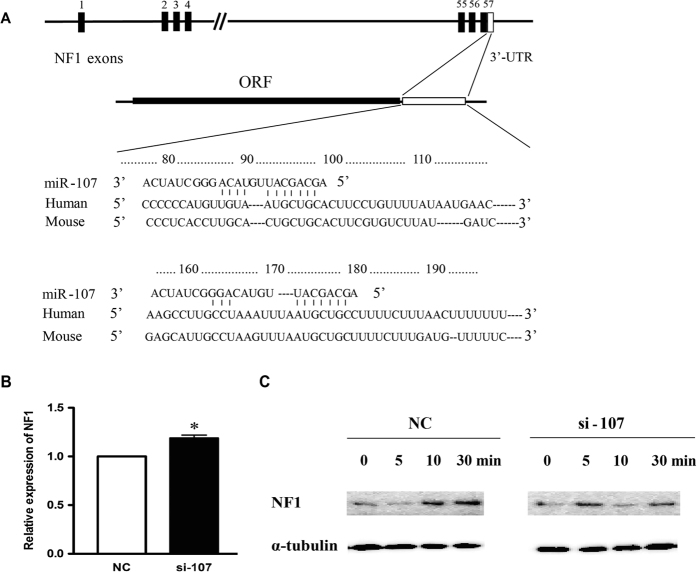
miR-107 targets NF1.(A) Schematic diagram of the NF1 3′-UTR containing two putative miR-107 binding sites. Below, sequence of mature miR-107 aligned to the two binding sites, showing evolutionary conservation in the seed-pairing sequence between human and mouse. (B) Down-regulation of miR-107 by si-107 resulted in an increased NF1 expression in MGC803 cells. (C) Down-regulation of miR-107 by si-107 resulted in an increased NF1 expression in MGC803 cells. MGC803 cells pre-treated with NC or si-107 for 48 h were serum starved for 12 h, and exposed to 10% serum for increasing lengths of time (0–30 min), and thereafter the expression of NF1 was evaluated. a-tubulin was used as internal control. *P < 0.05.